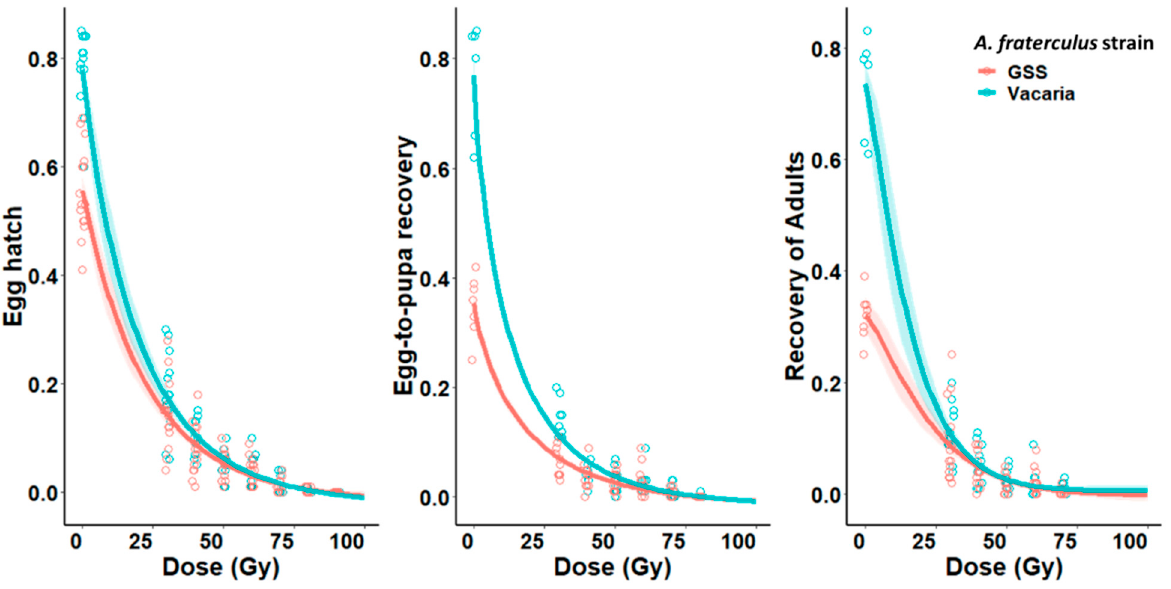
Figure 1. Weibull dose–response curves with 95% confidence intervals for three biological parameters resulting from crosses between fertile female Anastrepha fraterculus and males from a genetic sexing strain (GSS) and a bisexual strain (Vacaria) irradiated under hypoxia.